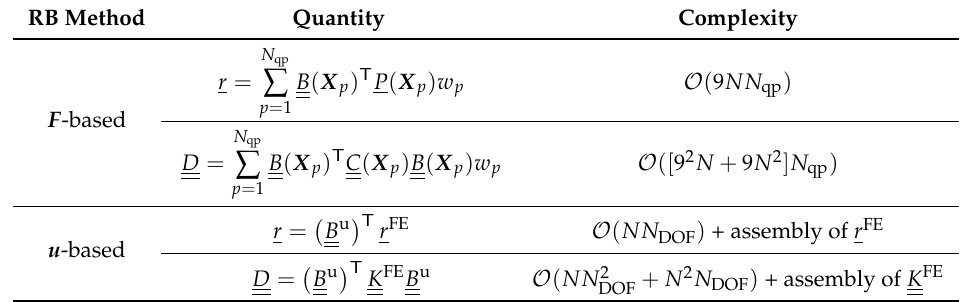
Table 1. Algorithmic complexities of the well-established u -based RB method and the novel F -based RB method. The assembly of the FE residual and of the FE stiffness depend on N qp